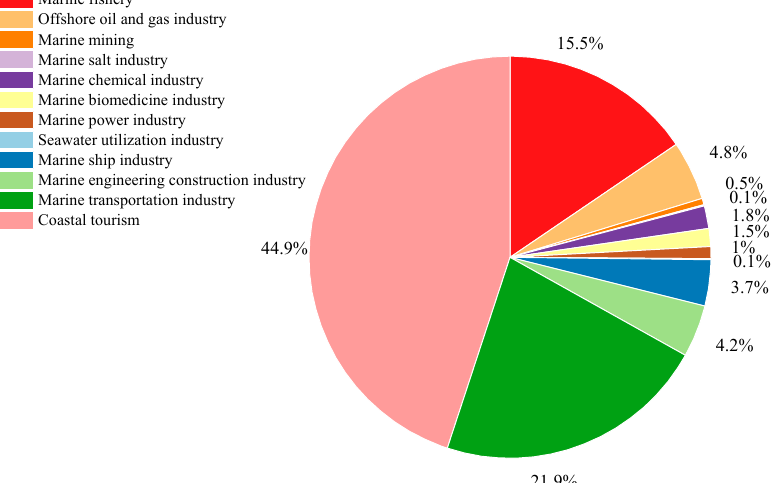
Figure 12. Contributions by major marine industries to the GDP of China’s marine economy in 2021 [36].